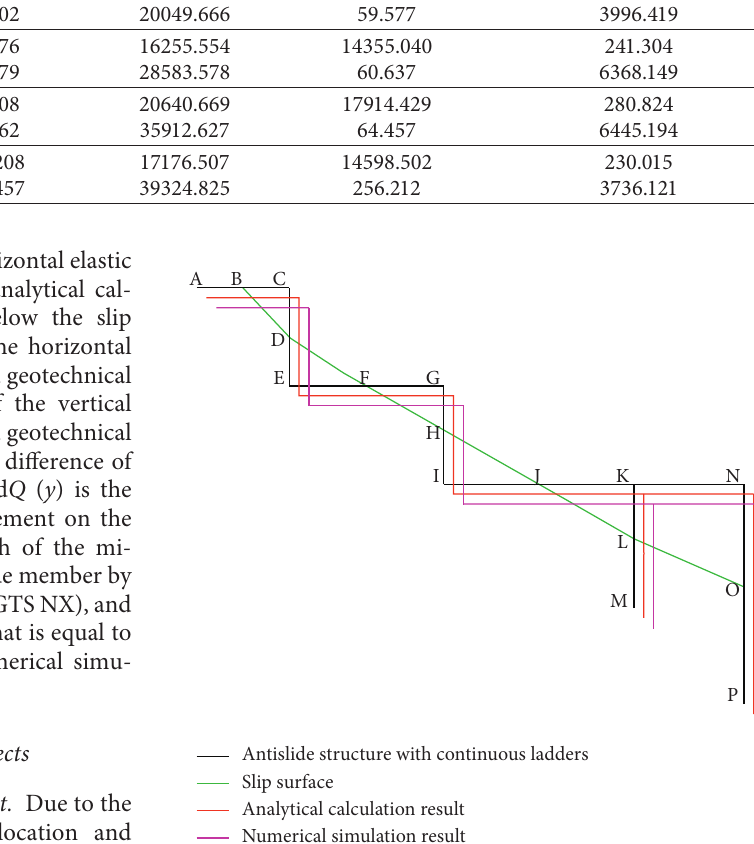
Figure 12: A comparative figure of the enlarged displacements. The black lines represent the initial shape of the ASCL, and the green lines represent the slip surface. Taking the initial shape of the ASCL as a standard, the red lines represent the displacements of the analytical calculations, while the pink lines represent the dis- placements of the numerical